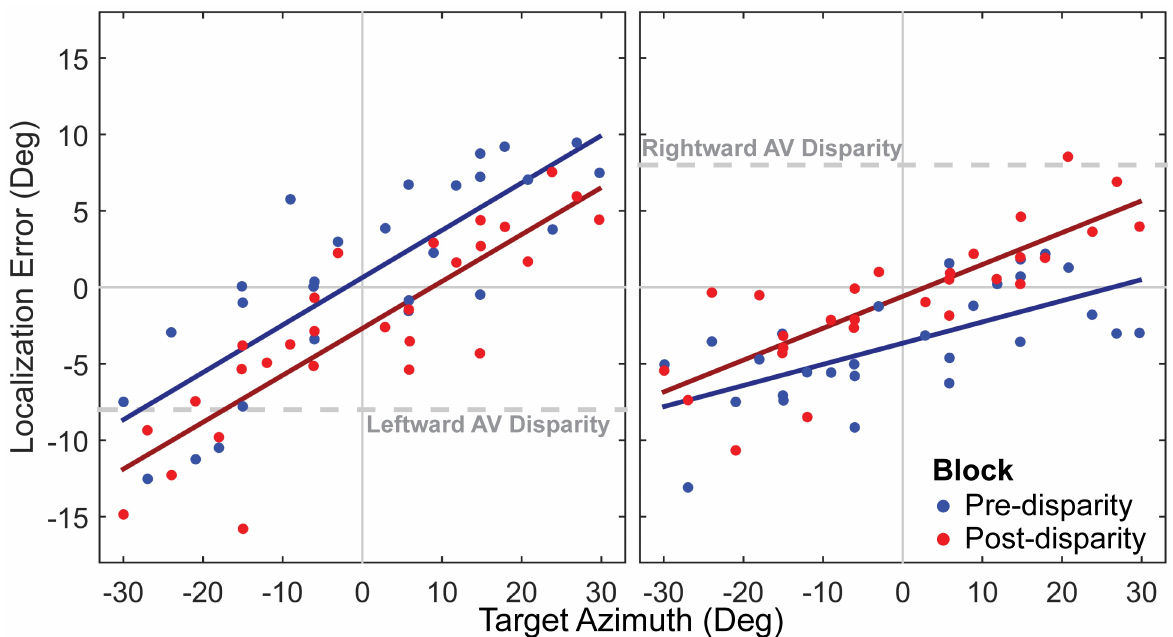
Fig 2. Example pre- and post-disparity auditory localization. left panel , Localization responses from one subject before and after exposure to leftward (visual − 8˚ azimuth relative to auditory) AV disparity. Blue and red circles represent localization response error as a function of target location in the pre-disparity and post-disparity blocks, respectively, and lines of the same color represent a linear fit to the data from each block. right panel , Shift in the same subject from exposure to rightward (visual +8˚ azimuth relative to auditory) disparity.